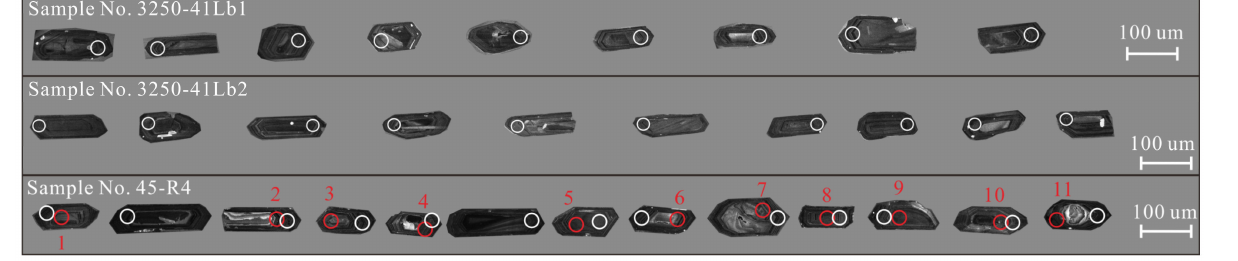
Figure 5. The CL images of zircons were analyzed for trace elements (white circles) and Hf isotopes (red circles and corresponding numbers) in quartz diorite of the Yangla Cu-W polymetallic deposit.